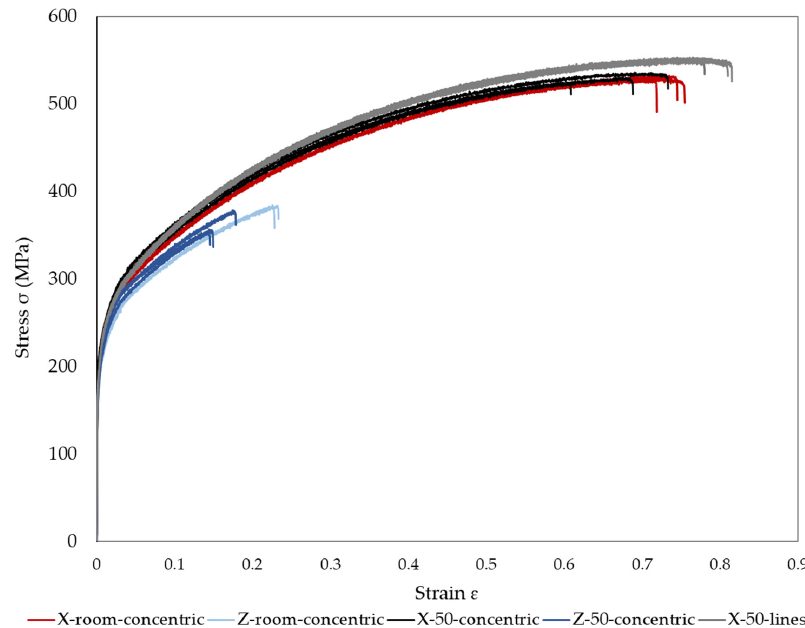
Figure 12. Stress–strain curves of machined coupons.